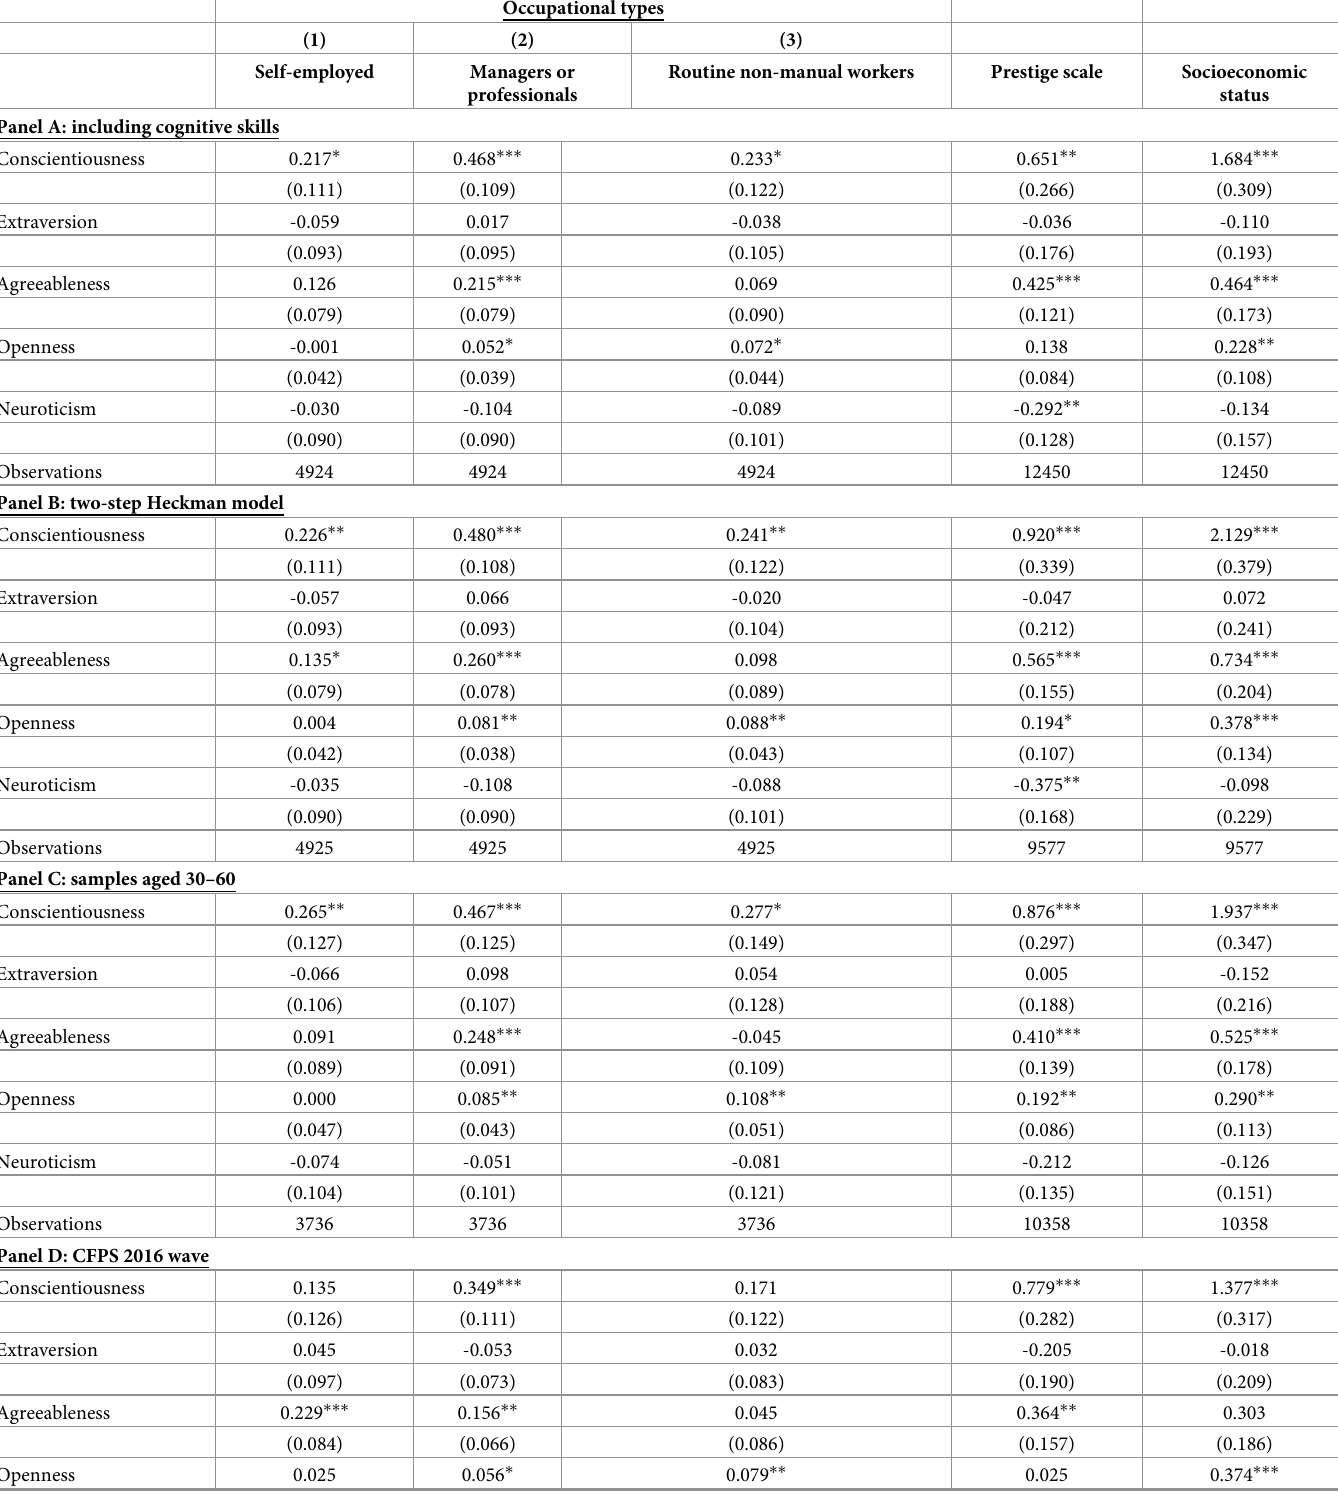
Table 5. Robustness